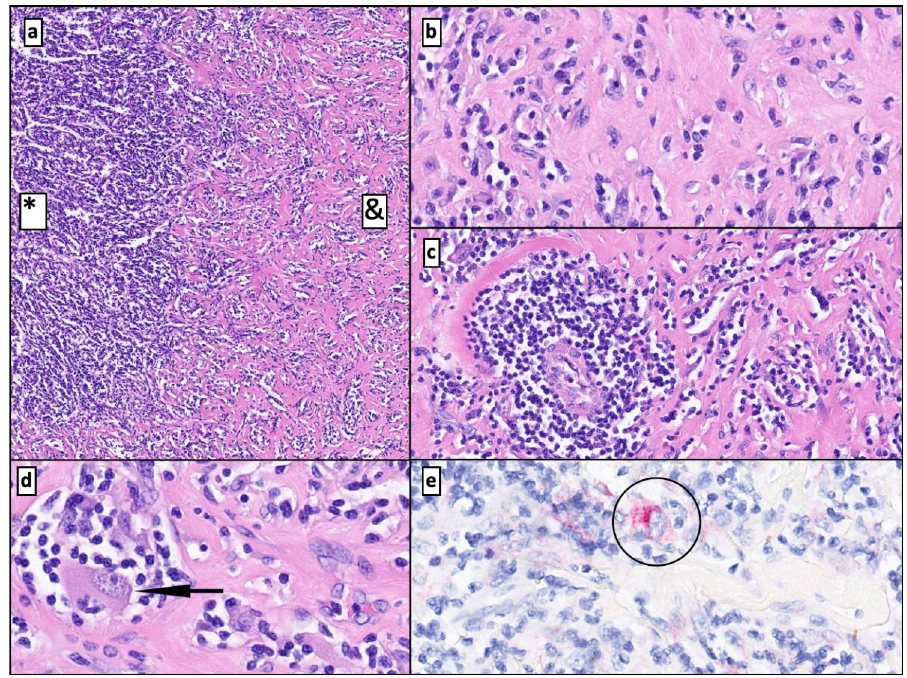
Fig. 5 Interphase zone with an inflammation-rich pseudovascular area (*) and a fibrous and sclerosing component (&) (a) . Fibrous neoplastic tissue with sparse epithelioid cells within the lymphoplasmacytic infiltrate (b) . Vessel surrounded by lymphoplasmacytic cells in the fibrosclerotic region (c) . Detail of a neoplastic cell: eosinophilic cytoplasm with distinct nucleoli next to lymphocytes and plasma cells (arrow) (d) . Cytoplasmic positivity for MelanA in a single cell in the fibrosclerotic region (circle)